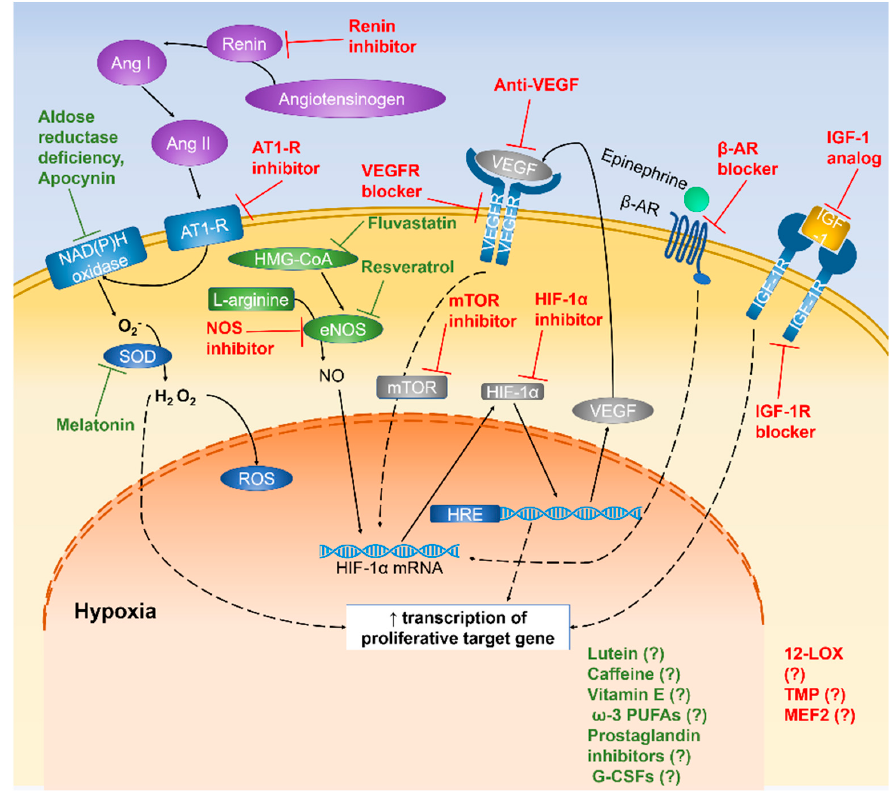
Figure 3. Schematic diagram representing the mechanism of vascular changes in hypoxic condition. Pathways that confer vascular protection are highlighted in red and neuroprotective pathways are highlighted in green.